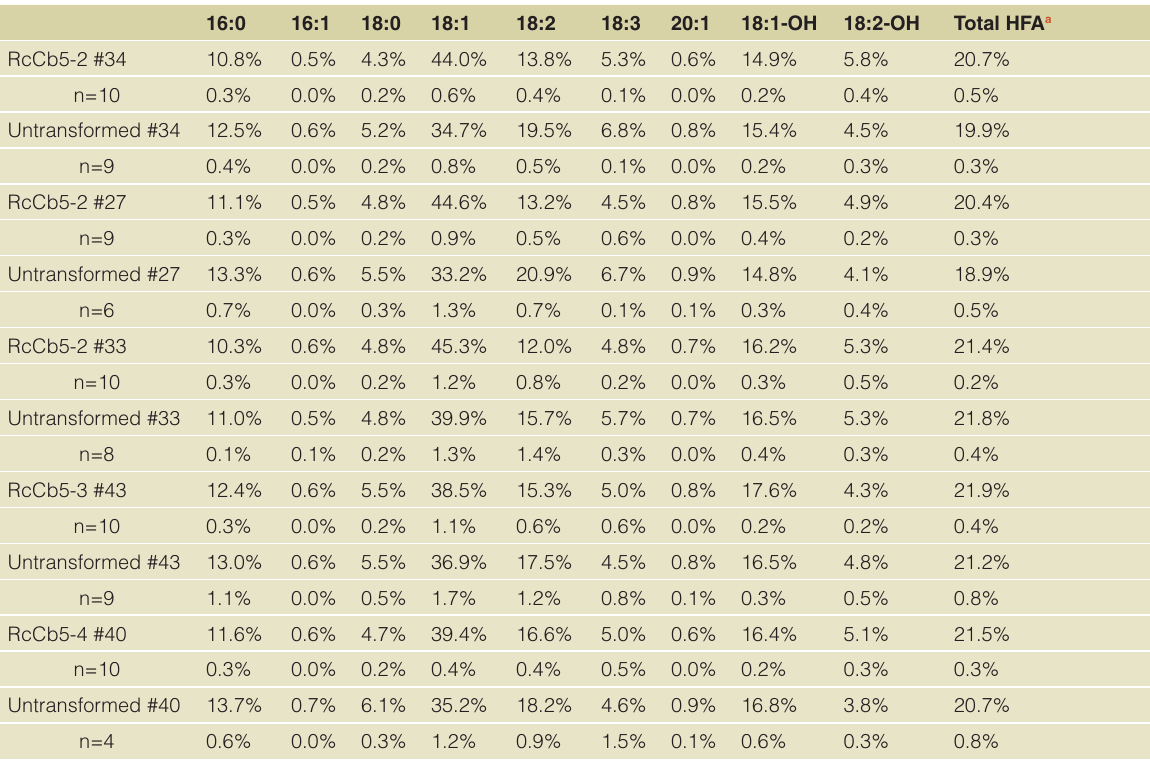
seed from selected T 3